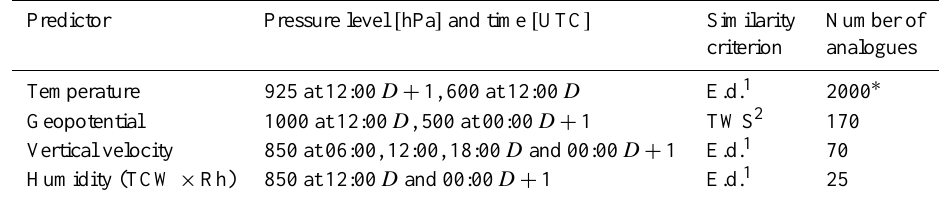
Table 1. Predictors and their corresponding pressure levels, times, similarity criterion and number of situations selected in the given step used by the downscaling